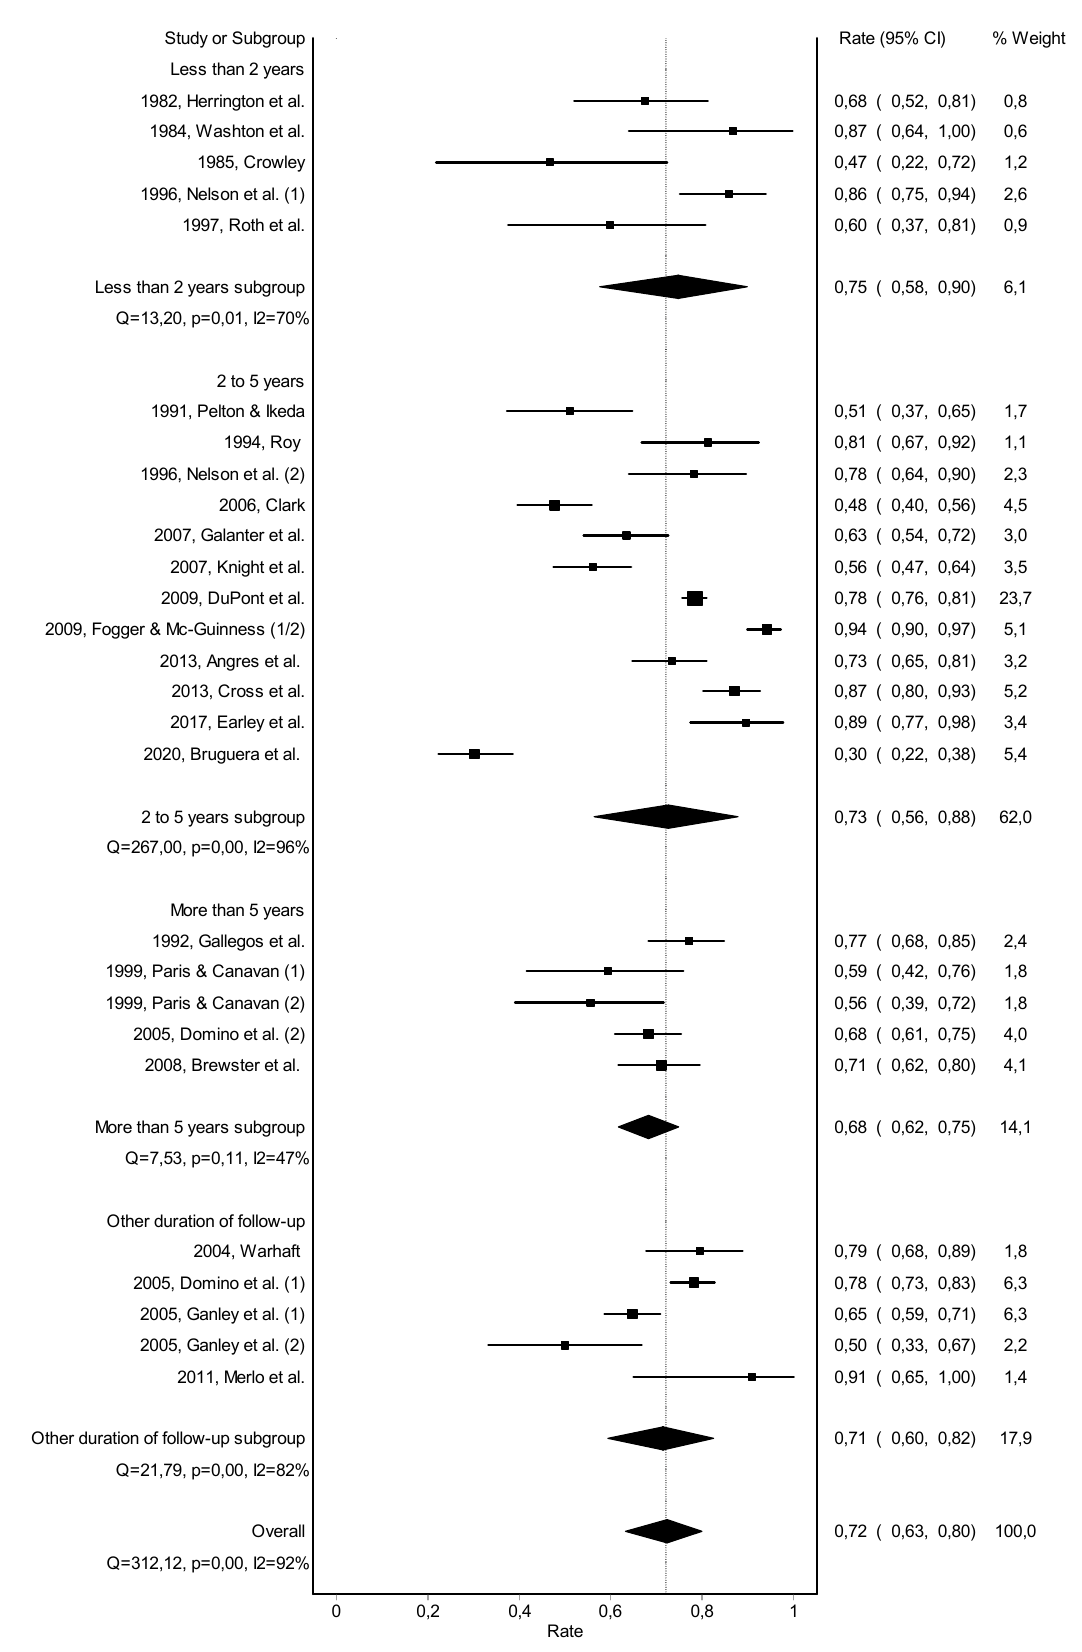
Figure A2. Forest plot of the pooled abstinence rate—subgroup analysis based on duration of follow-up.